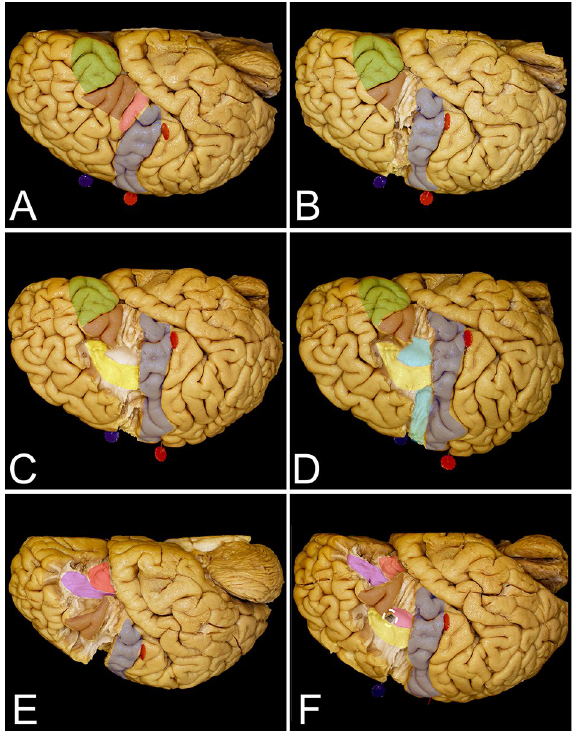
Figure 4. The figure presents the location of the main white matter tracts with a lateral trajectory. ( A ) The key cortical regions that need to be identified are the precentral cortex (blue), pars opercularis of the IFG (pink), pars triangularis (burgundy) and pars orbitalis (green). ( B ) The most superficial layer of the fibers, which are identified just under the cortex, is composed of the short association u-fibers that connect the neighboring gyri of the frontal lobe. Here, u-fibers within the premotor area are present after removal of the cortex just anterior to the precentral gyrus. ( C ) The most superficial bundle of long association fibers is formed by the AF/SLF complex (yellow) running around and superficial to the insular limiting sulcus. Within the frontal lobe, anterior to the precentral gyrus, this bundle can be identified at the level of the middle frontal gyrus, aiming for the pars triangularis of the IFG. The most superficial layer from the lateral perspective is formed by the second segment of the superior longitudinal fasciculus (SLF II), which connects the middle frontal gyrus to the inferior parietal lobule. The SLF III and AF terminate within the posterior parts of the inferior frontal gyrus. ( D ) Removing the AF/SLF complex in front of the precentral sulcus exposes the vertical short association white matter tract, the frontal aslant tract (FAT) (light blue), which connects the SMA complex with the pars opercularis of the IFG. The mesial part of the FAT, which connects the SMA complex with the caudate nucleus, forms the frontal striatal tract (FST)—not seen here (Fig. 3D). ( E ) The ventral long association bundle is formed by the IFOF/UF complex, terminating within the basal part of the frontal lobe. The frontal lobe is connected with the temporal pole through the UF (red) and with the parietal and occipital lobes through the IFOF (purple). This layer of white matter forms the external and extreme capsule. ( F ) From this perspective, the frontal horn of the lateral ventricle (white circle) is identified just posterior to the pars triangularis and below the AF/SLF